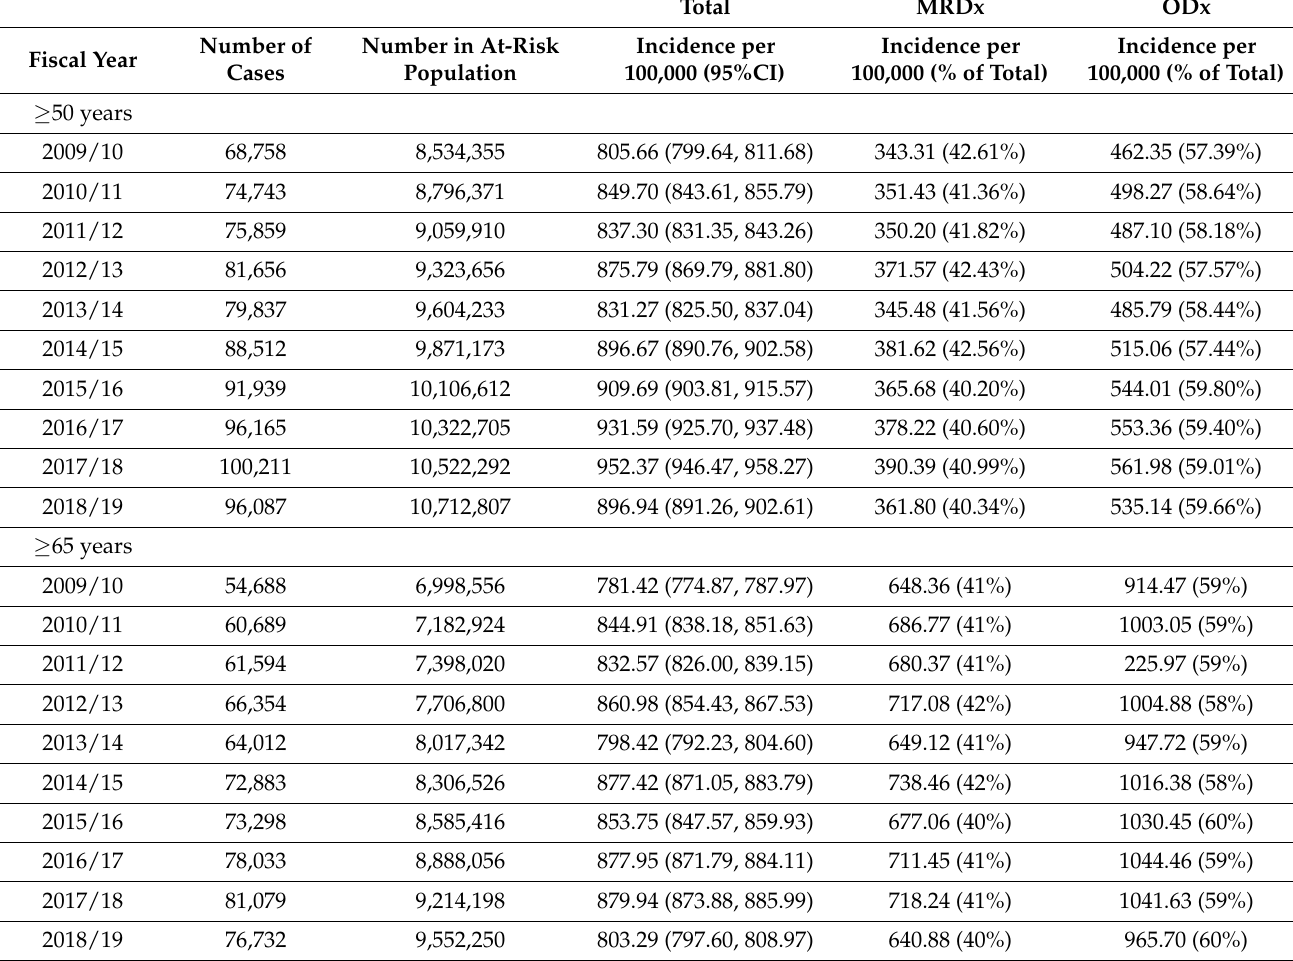
Table 1. Incidence rates of acute-care hospitalization for all-cause community-acquired pneumo- nia among adults ≥ 50 and ≥ 65 years of age, by case coding, in fiscal years 2009–2018, Canada (excluding